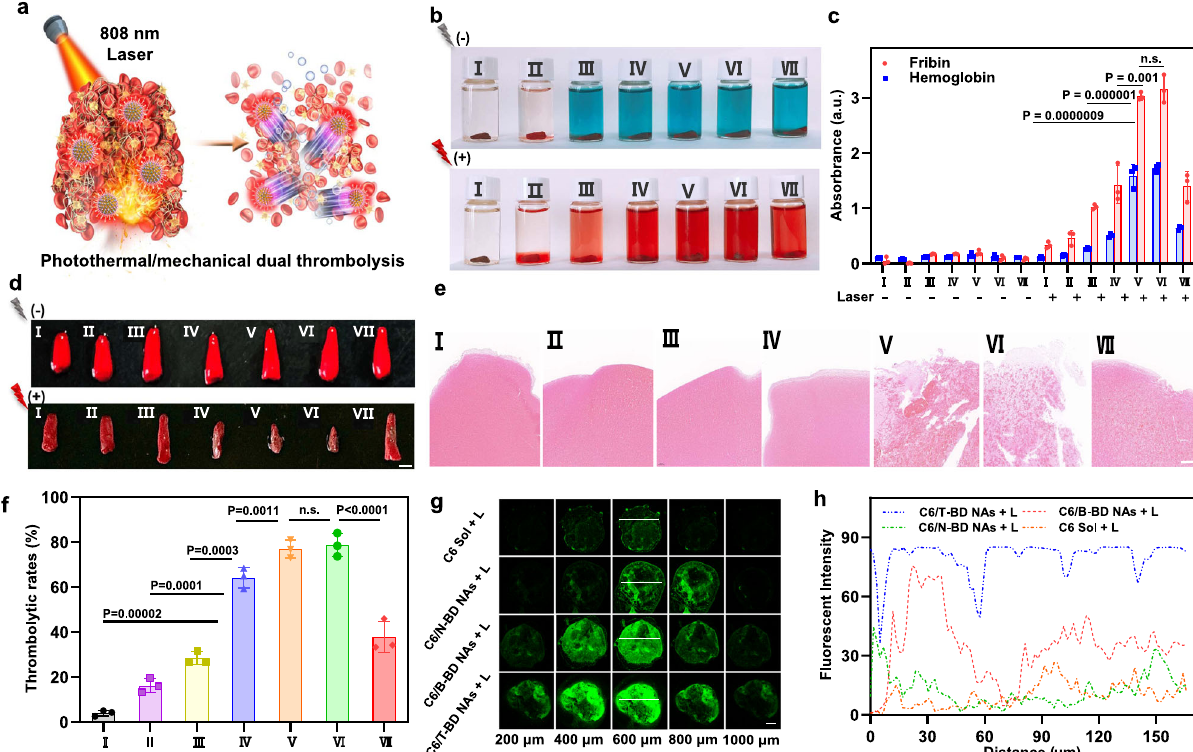
Fig.4|Invitrosynergisticthrombolysisandclotdeeppenetration.a Schematic representation of photothermal/mechanical synergistic thrombolysis and clot- deep penetration. b Photos of blood clots after different treatments with/without the808nmNIRlaserirradiation:(2W/cm 2 ,20min). c Fibrinandhemoglobinlevels in the blood clot supernatants after different treatments with/without the 808nm NIR laser irradiation. Data are presented as mean±SD ( n =3, independent experi- ments).SourcedataareprovidedasaSourceData fi le.One-wayANOVA(one-sided) with Dunnett ’ s multiple comparisons test was used for the analysis of data and adjusted P value.The n.s.represent no signi fi cance. d Images of blood clots before and after differenttreatments with808nmNIRlaserirradiation(2W/cm 2 ,20min), scale bar=2mm. e H&E staining results of d under 808nm NIR laser irradiation